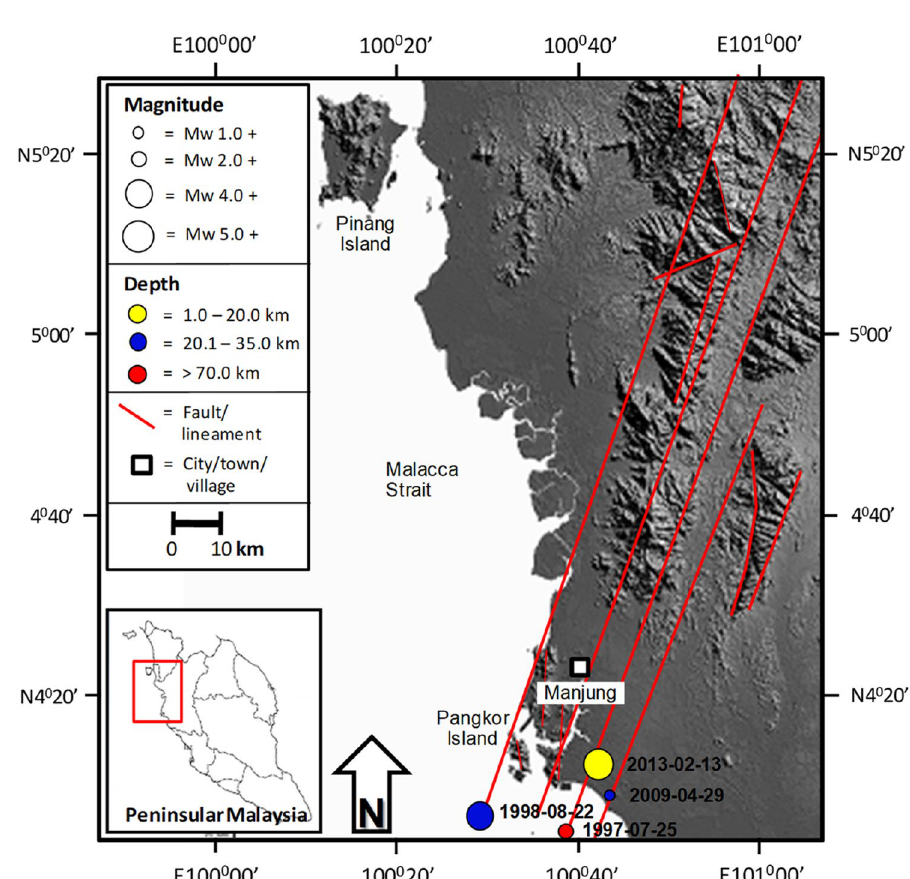
Fig. 7 Four local earthquakes, which occurred on November 29 and 30, 2009, were plot- ted on SRTM–DEM image of Seremban-Kuala Pilah area. These events were interpreted as the result of the reactivation of the Bentong–Raub Suture Zone and Seremban Fault Zone. Red thicker lines indicate known main faults, while red thinner lines are lineaments indicating possible faults. Note: Created with CorelDraw